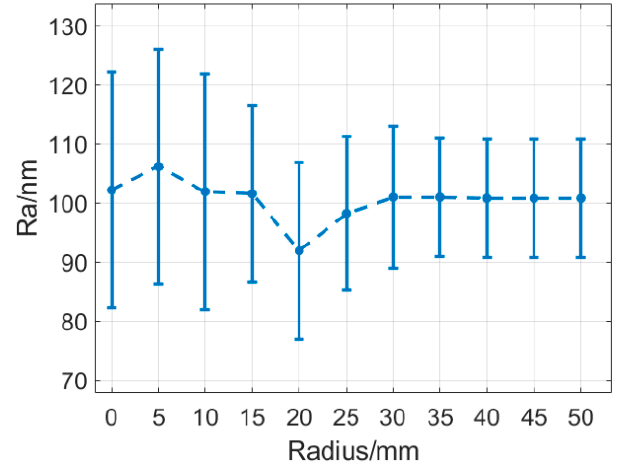
Figure 7. Change in roughness from the center to the edge of the workpiece.